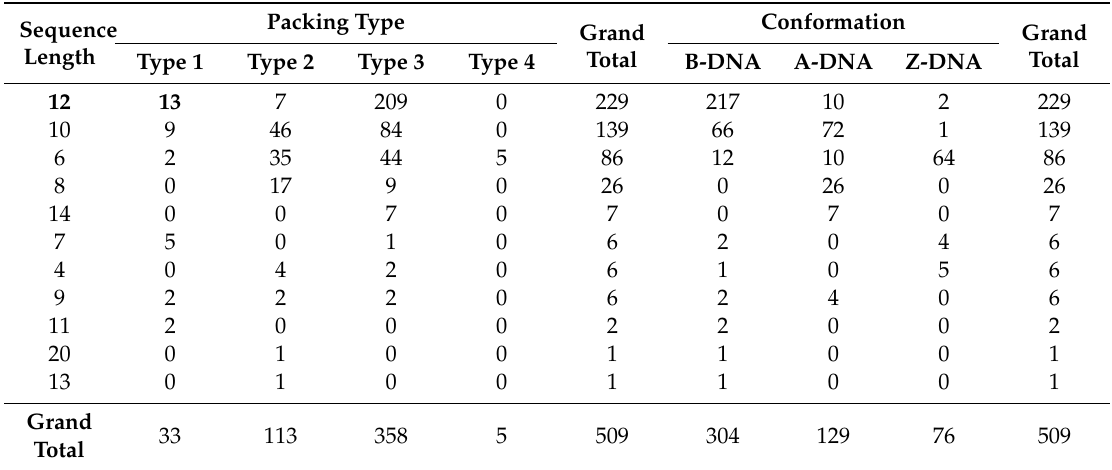
Table 3. Number of DNA structures of different sequence lengths, their packing types, and conformations. Sequence